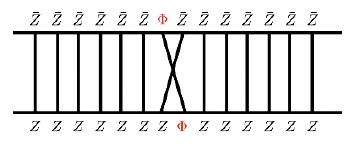
Figure 1 . Commutator